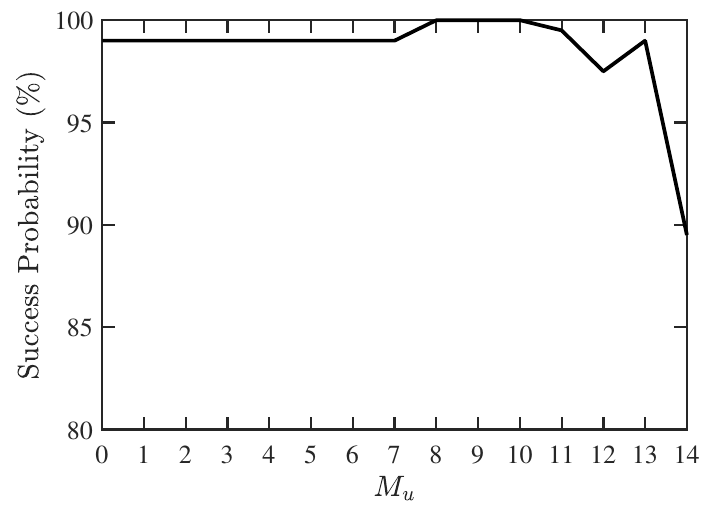
Figure 5. Success probability of DOA and CF estimation with proposed PJE algorithm, under different numbers of signals with unknown CF, SNR = 10 dB, Q = 300, M = 30.